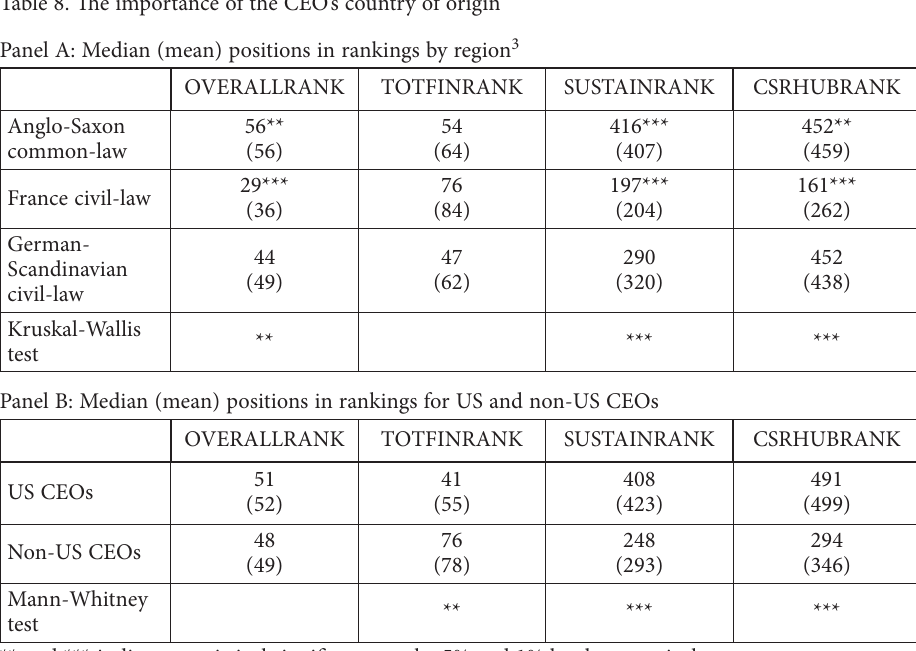
** and *** indicates statistical significance at the 5% and 1% level,